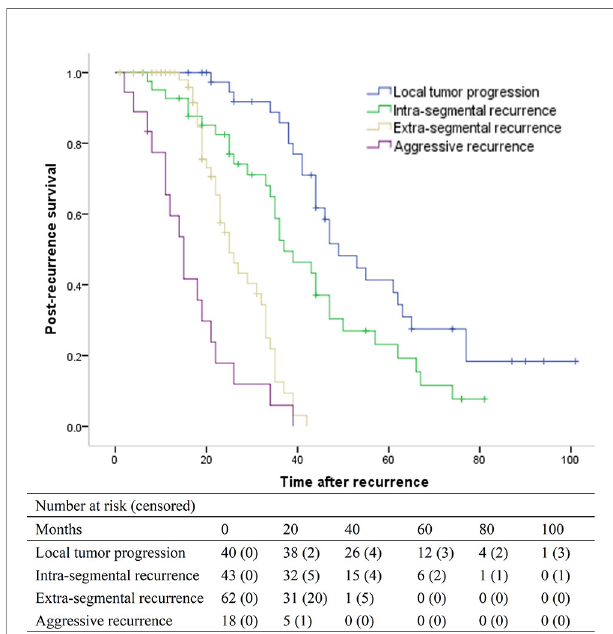
FIGURE 4 | Kaplan-Meier curves of post-recurrence survival in patients with local tumor progression (median, 49 months), intra-segmental recurrence (median, 37 months), extra-segmental recurrence (median, 25 months), and aggressive recurrence (median, 15 months), respectively (overall P